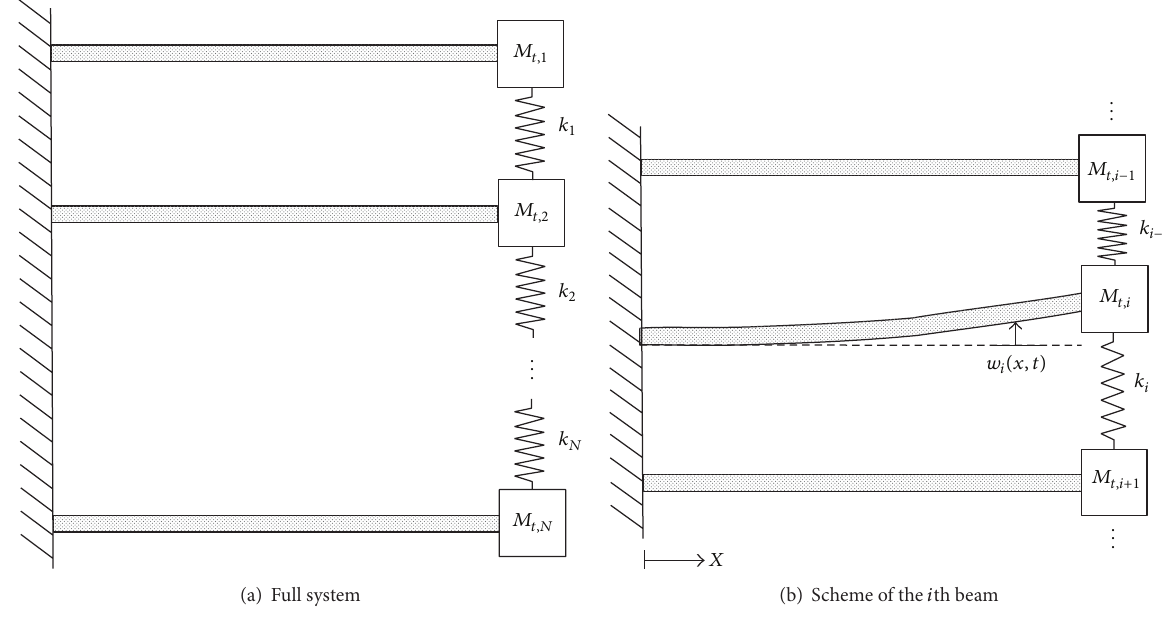
Figure 2: Structure consisting in an array of piezoelectric beams connected by